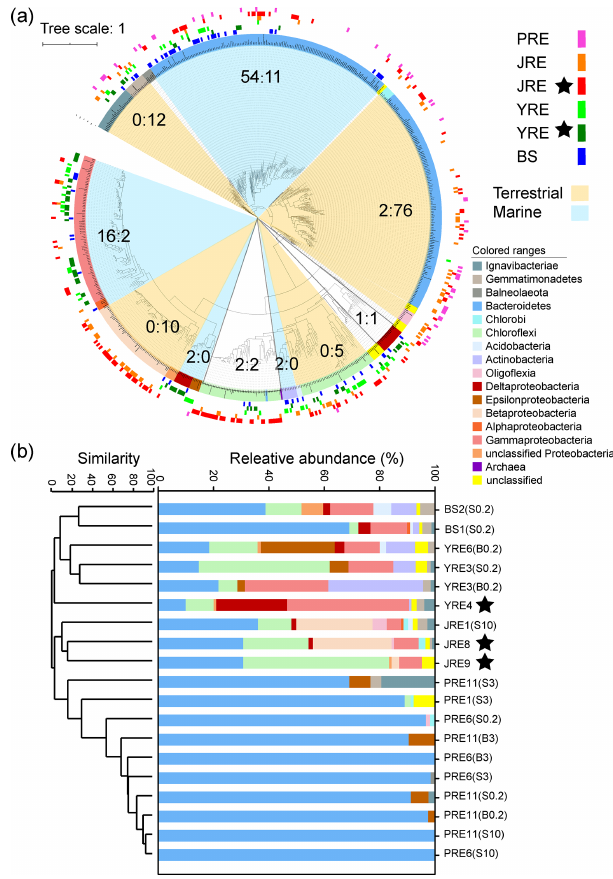
Figure 4. (a) Maximum likelihood phylogenetic tree of amino acid sequences of the clade II-type nosZ . The colors of the inner circle in- dicate taxonomic affiliations based on reference sequences. The col- ors of the outer circles represent the sources of clone sequences. The phylogenetic tree was bootstrapped 500 times. The scale bar repre- sents the number of amino acid substitutions per site. Numbers be- fore and after the colons indicate the number of reference sequences from marine and terrestrial habitats, respectively. The figure was produced using the interactive tree of life (http://itol.embl.de/, last access: 20 September 2019; Letunic and Bork, 2016). (b) Relative abundances of community compositions of the clade II-type nosZ gene clone libraries in the four estuaries. The colors of the bars indicate taxonomic affiliations. The similarity was calculated from Bray–Curtis similarity. Black stars indicate sediment